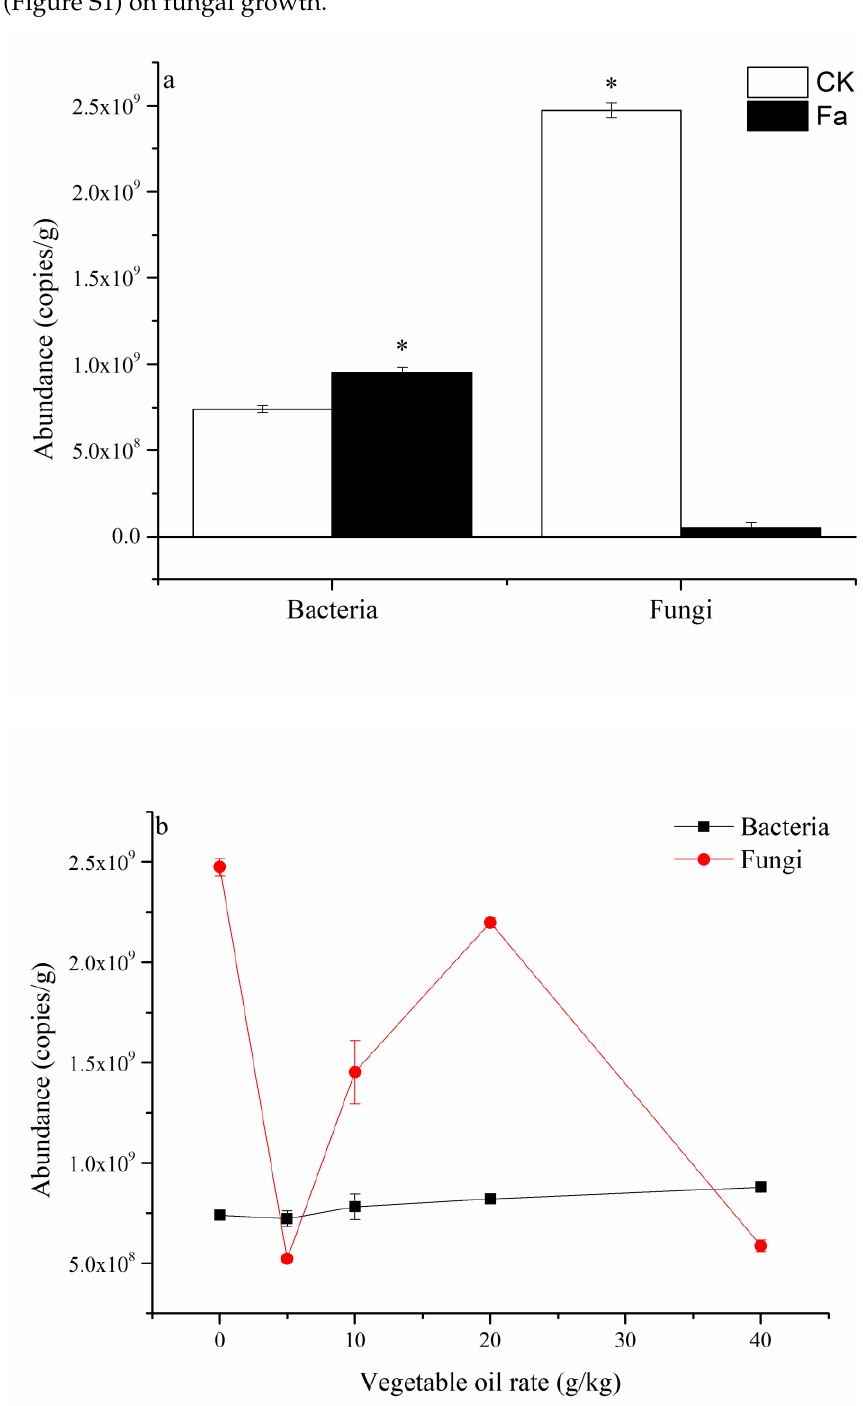
Figure 1. Soil bacterial and fungal abundance in the control (CK), fertilizer input alone (Fa), and vegetable oil alone (VOa): ( a ) CK and Fa on day 8, ( b ) VOa on day 8. Data shown are the means of three replicates, and * indicates significance at 0.05.